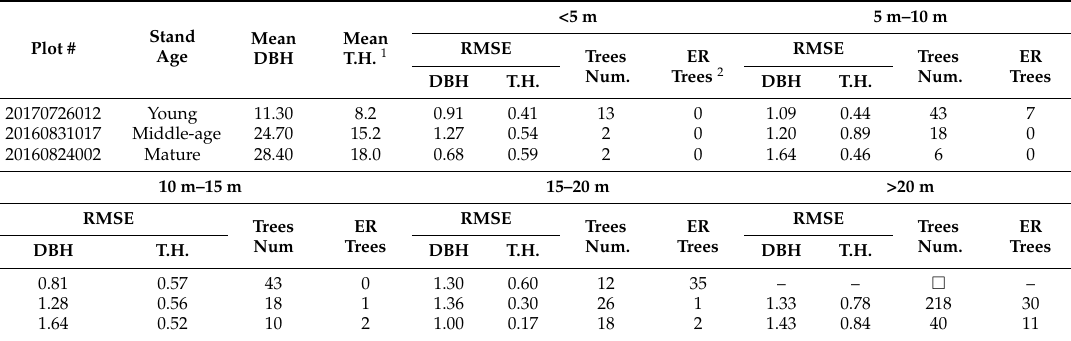
Table 4. Effects of Forest Density and Distance on Scanning Range and Accuracy.